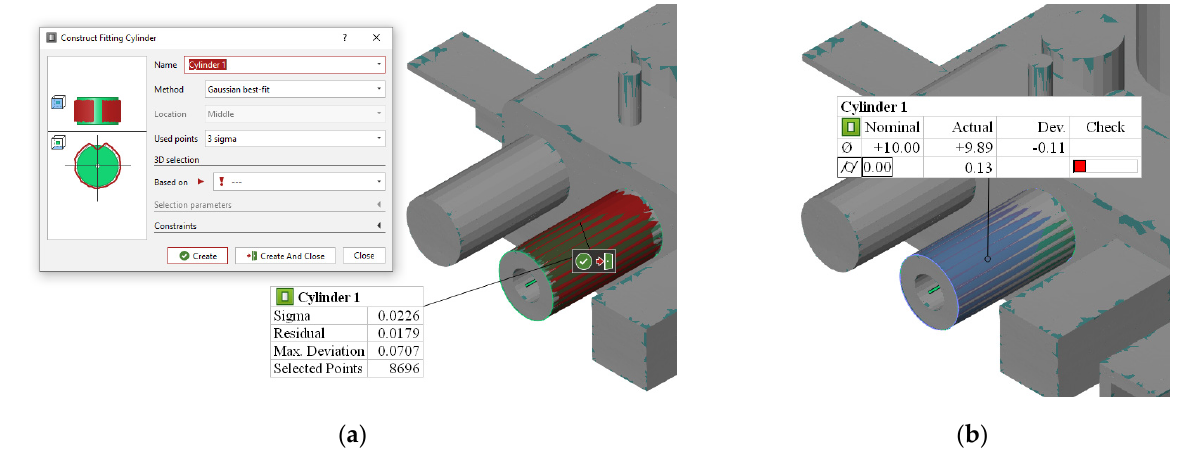
Figure 6. Extraction of GD&T: ( a ) construction of fitting feature on deviated STL and ( b ) extraction of GD&T characteristics based on the constructed feature.